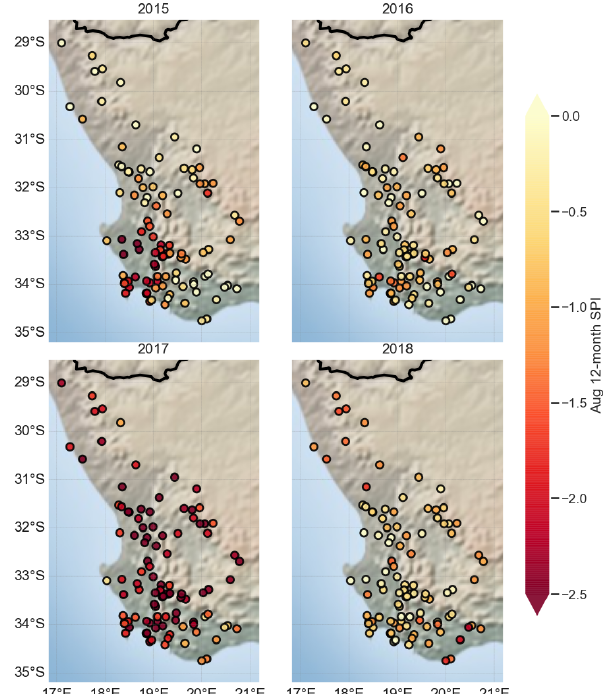
Figure 3. Twelve-month SPI for the periods ending in August of the years